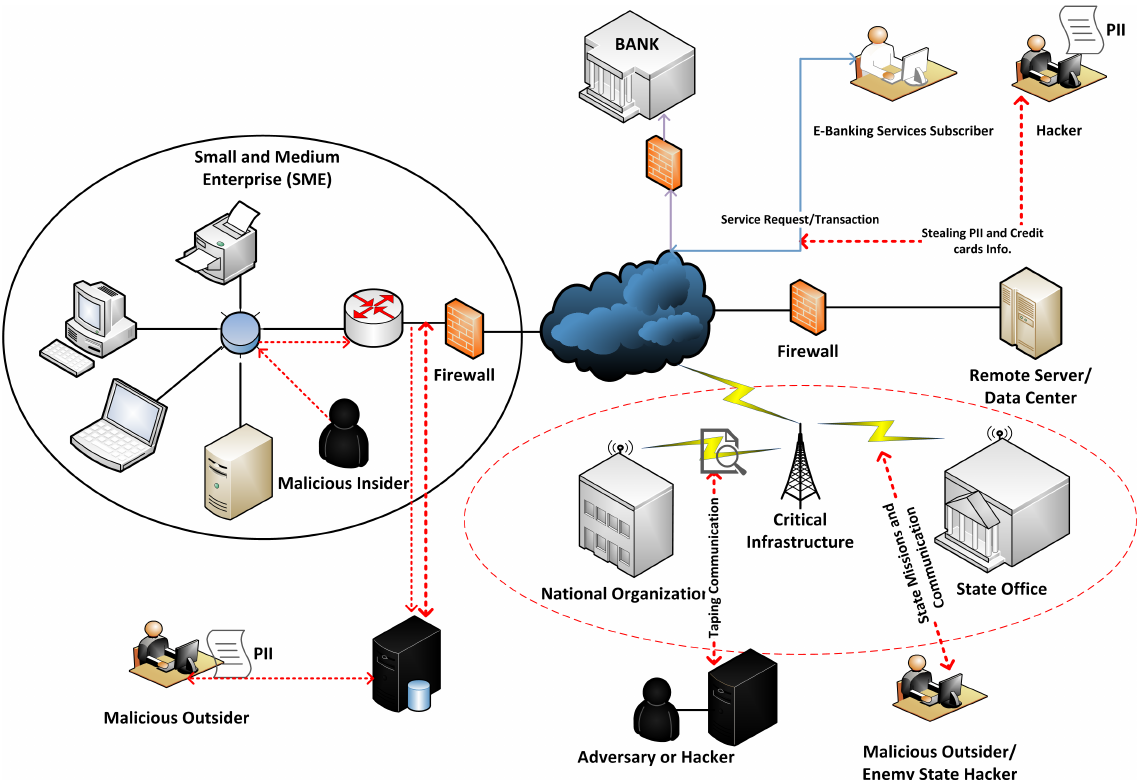
Figure 1. Large attack surface exposed by the connected infrastructure cause data